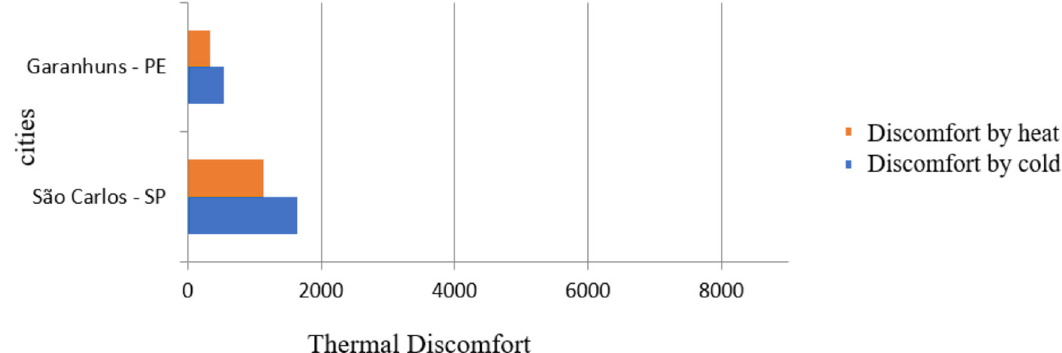
Fig. 8. Total discomfort in ° C h due to cold and heat for cities in Garanhuns and São Carlos. Table 4. Summary of results obtained for the best models in different orientations. ° CH COLD ° CH HEAT ° CH